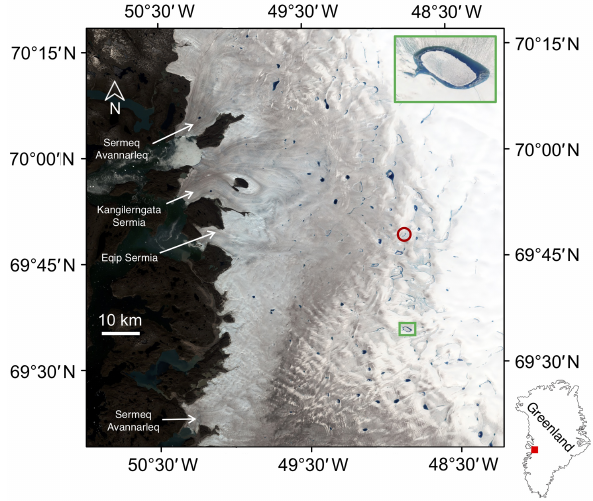
Figure 1. The ∼ 12000km 2 study site within Greenland (in- set). The background image is a Sentinel-2 RGB image from 11 July 2016 (see Table S1 for image details). The green box and en- larged subplot show a rapidly draining lake and the red circle shows a non-rapidly draining lake (see Fig.